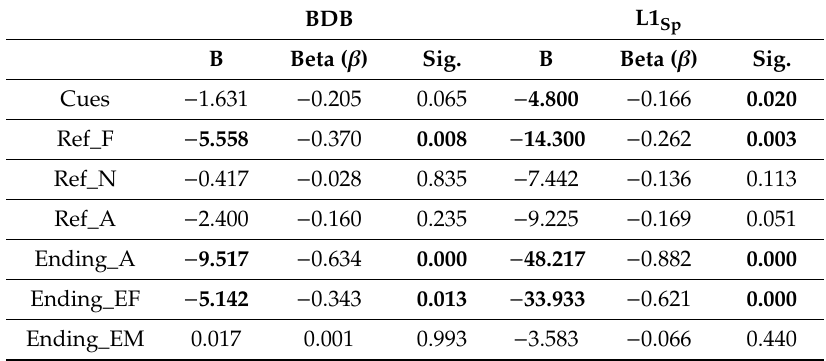
Table 7. Likelihood of not assigning MASC gender to the pseudoword, across